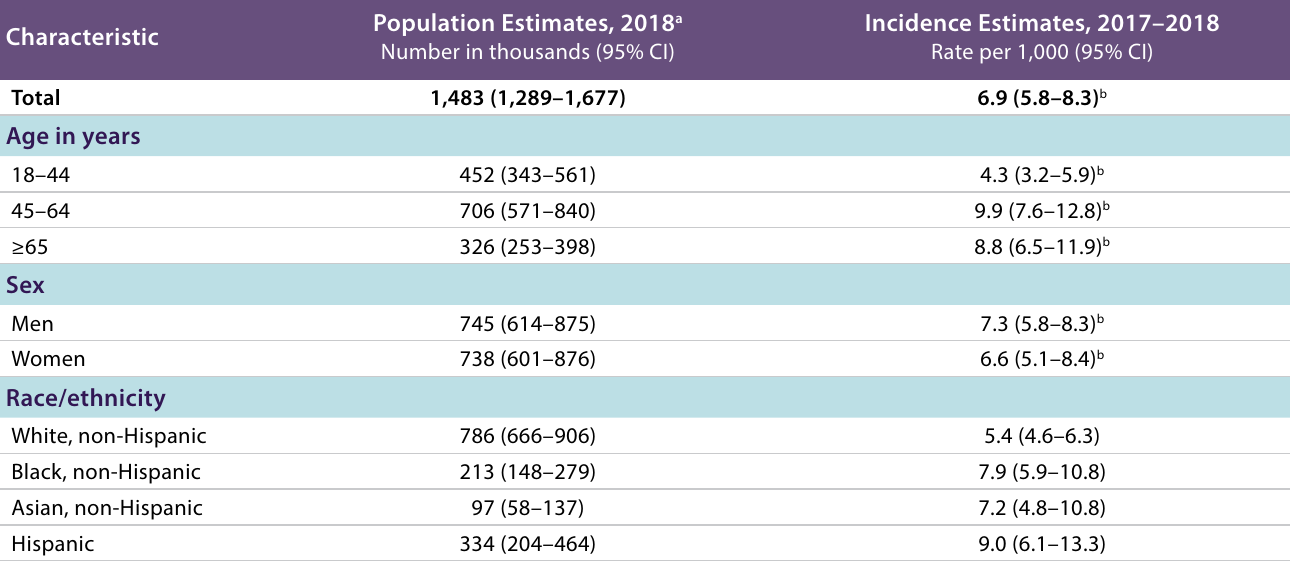
Table 2. Estimated crude incidence of diagnosed diabetes among adults aged 18 years or older, United States,